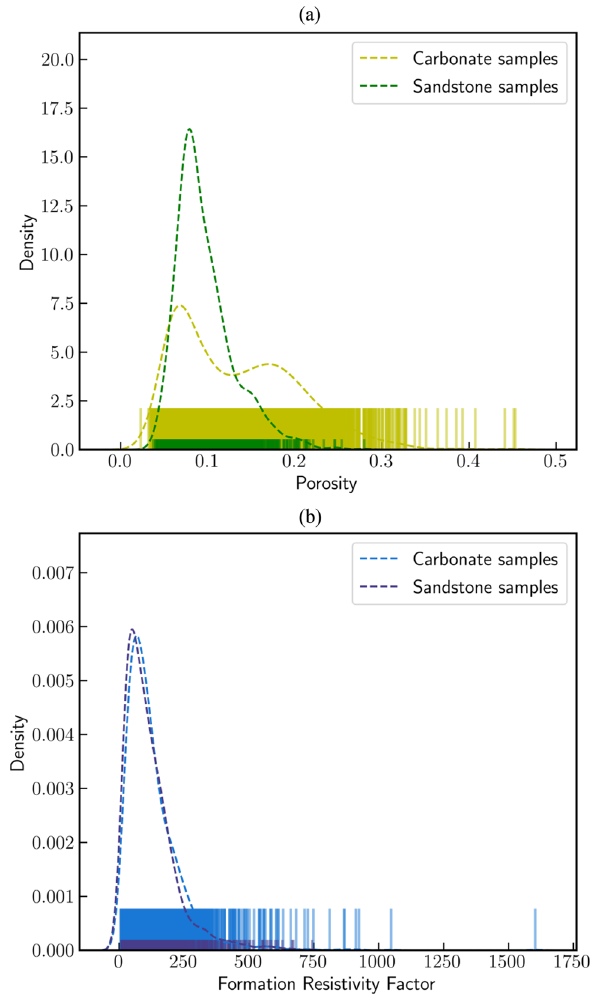
Fig. 1 a Distribution of porosity for carbonate and sandstone sam- ples, and b distribution of formation resistivity factor for carbonate and sandstone samples